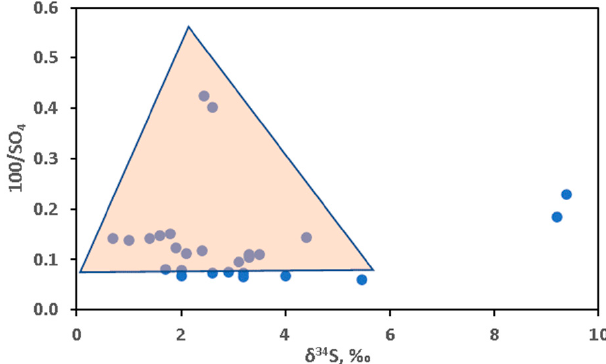
Figure 6. Reciprocal sulfate concentration vs. δ 34 S for agricultural drains and seeps between Fabens and Fort Hancock. The brown triangle corresponds to the field of post-dam groundwater in Figure 5.